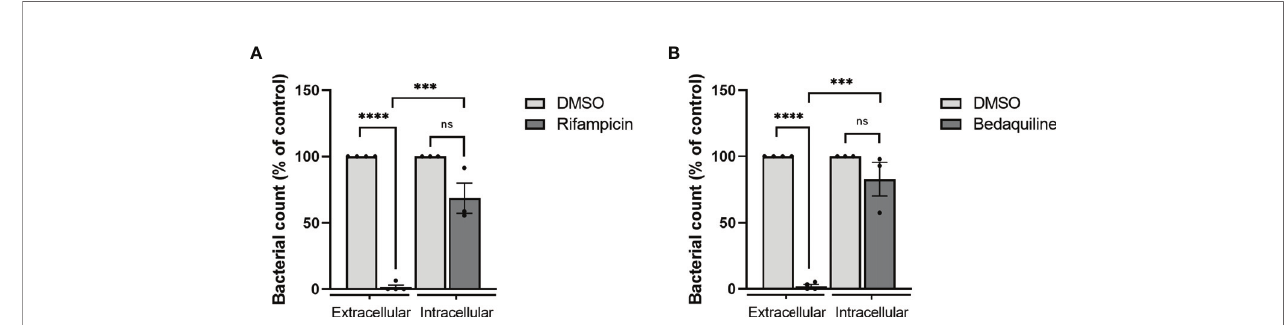
FIGURE 4 | Evaluation of drug susceptibility of Mav Wasabi extracellularly in liquid broth versus intracellularly in primary human macrophages. To determine differential susceptibility of intracellular versus extracellular Mav to antibiotics, Mav Wasabi in liquid broth was cultured with a range of concentrations of rifampicin (A) , bedaquiline (B) , or control (DMSO). Bacterial outgrowth was monitored by absorbance measurements at 600 nm. After 14 days of incubation, the minimum concentration in which rifampicin (A) and bedaquiline (B) was assessed was 1.29 m g/ml and 1.74 m g/ml, respectively, and was used for intracellular activity evaluation. Pro-in fl ammatory macrophages (M1) were infected with an MOI 10 of Mav Wasabi for 1 h. After infection, cells were treated with rifampicin (1.29 m g/ml), bedaquiline (1.74 m g/ml), or control (DMSO) for 24 h. After treatment, cells were lysed, and intracellular bacterial loads were determined by the MGIT system. The bar and whiskers represent the mean ± SEM of extracellular ( n = 4) or intracellular ( n = 3) experiments. Statistics were performed using paired t -tests to compare the activity of antibiotic to control within each type of experiment, and unpaired t -tests were used to determine differences between potency of antibiotic against extracellular versus intracellular bacteria. *** p < 0.001, **** p < 0.0001; ns, non-signi fi cant.